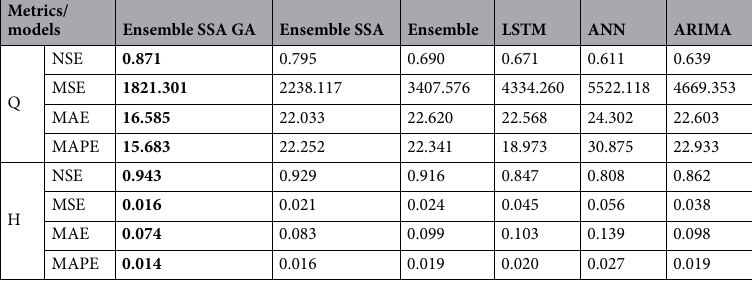
Table 8. One-step-ahead Forecasting for Kon Tum dataset. Best results are highlighted in bold text. Our proposed method (i.e., Ensemble SSA GA) outperforms the others.